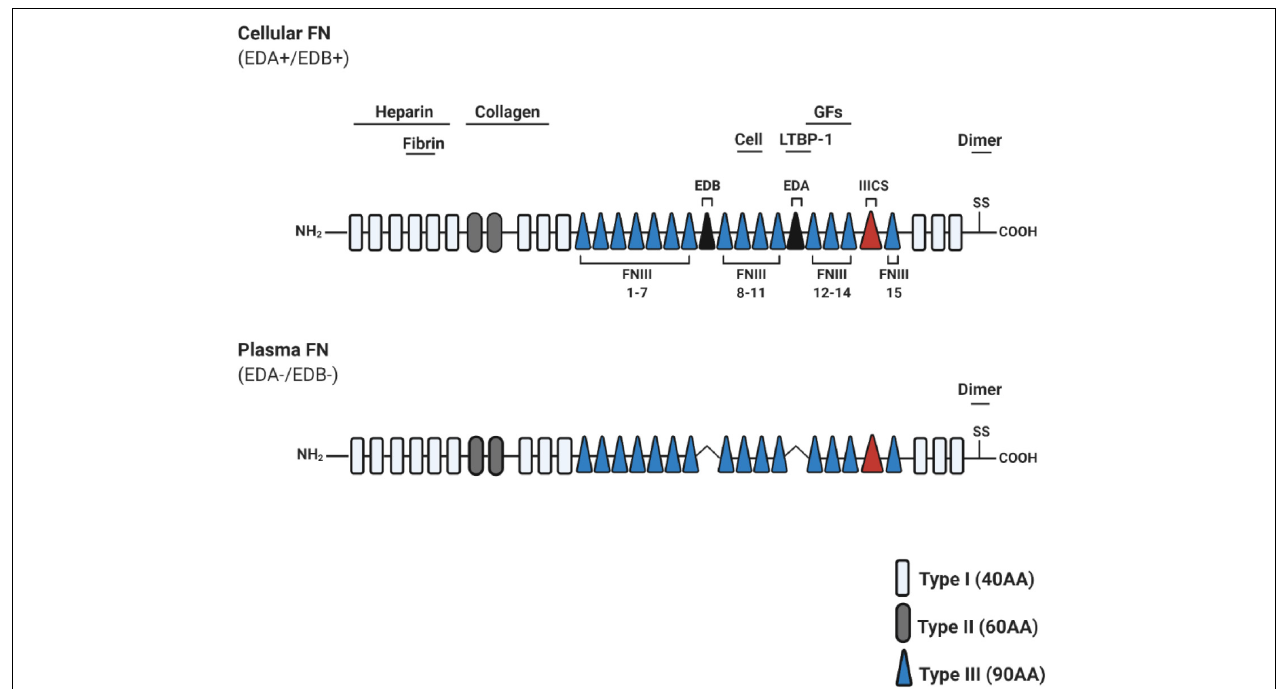
FIGURE 2 | Schematic illustration of fibronectin primary structure. Fibronectin (FN) is constitutively composed of evolutionarily conserved repeats: Type I (FNI; 12 units), Type II (FNII; 2 units), and Type III (FNIII; 15 units). Two FN monomers bind at the C-terminal dimerization site. Cellular FN isoforms are composed of alternatively spliced extra domains A/B (EDA/EDB), and variable portions of type III connecting segment (IIICS). Plasma FN lacks both EDA and EDB domains entirely. Known heparin, collagen, and fibrin-binding domains are depicted throughout FN, along with a promiscuous growth factor (GF)-binding domain (FNIII repeats 12–14). FNIII repeats 9–10 contain RGD motifs to bind integrins which mediate cell attachment and downstream signaling. Abbreviations used: growth factors (GFs), amino acids (AA), extra domain A/B (EDA/EDB), type III connecting segment (IIICS), arginine-glycine-aspartate